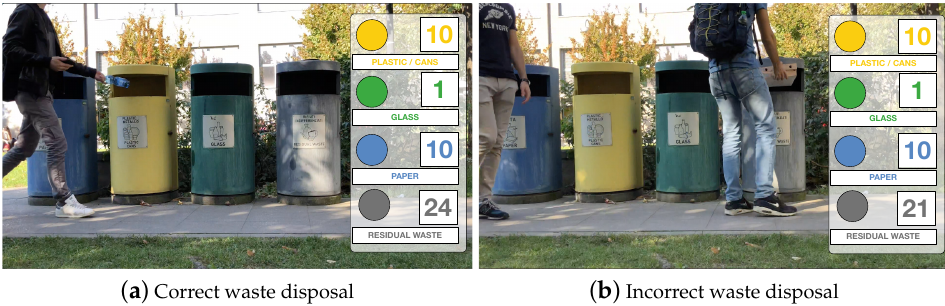
Figure 1. Two frames of the recordings used for analysing the student’s behaviour. The average interaction time is estimated from the